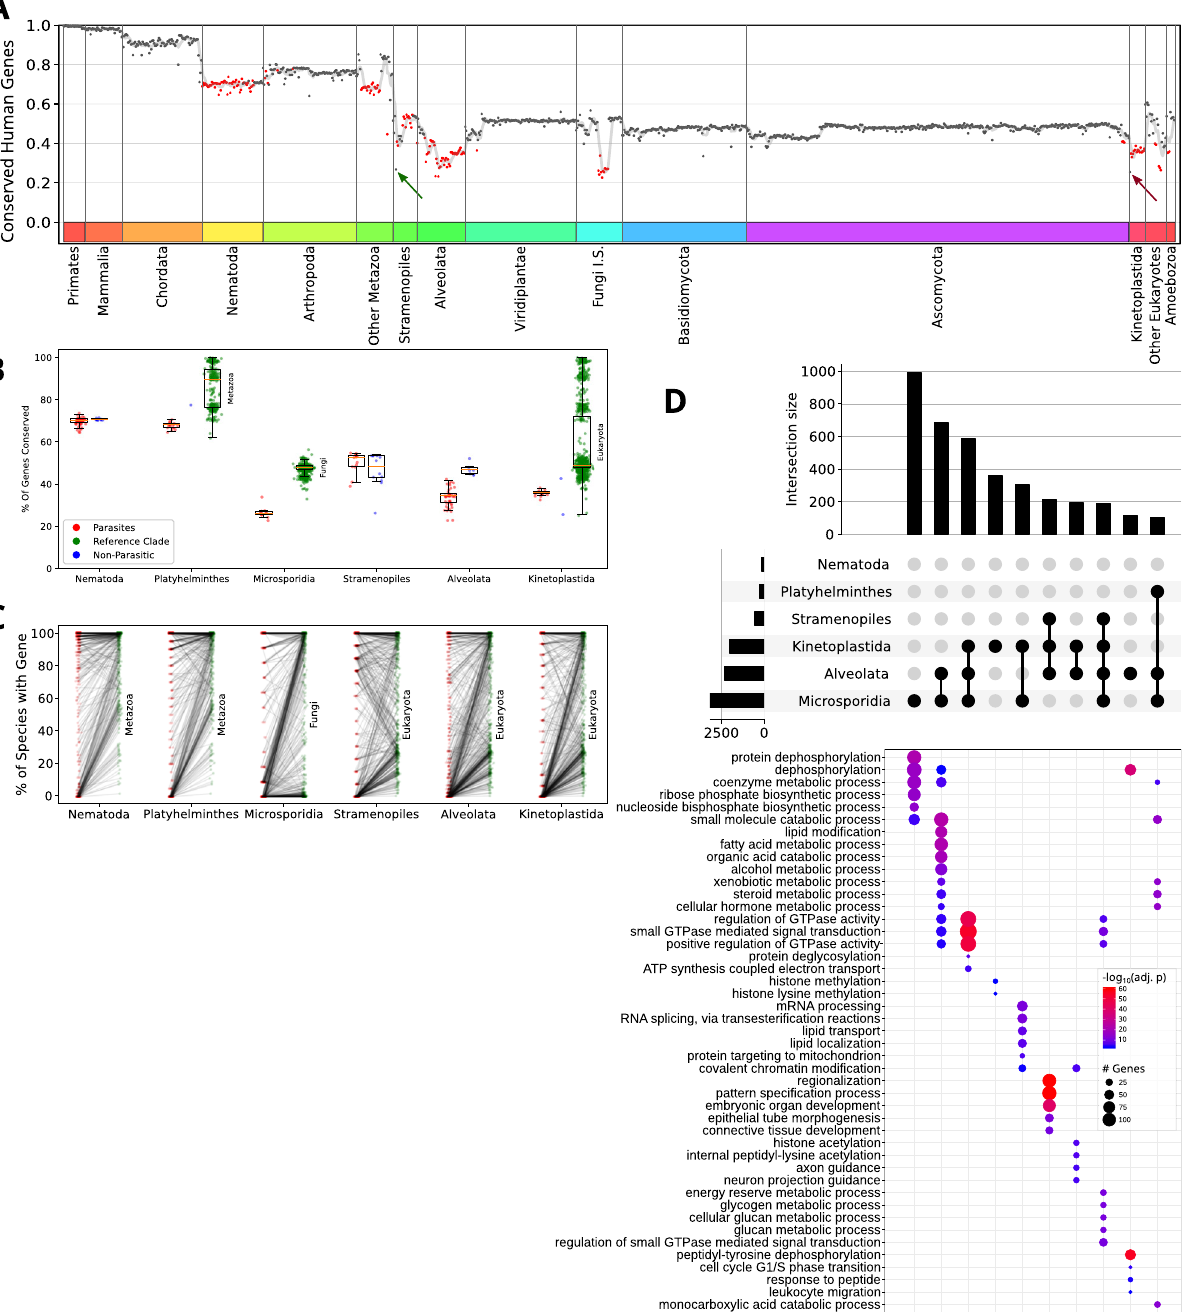
Fig. 7 Parasitic clades provide a key phylogenetic pro fi ling signal. The proportion of human genes found in each organism is shown on the y-axis, with parasites marked in red. Two non-parasitic organisms with lower conserved genes fraction are highlighted in green ( Nannochloropsis gaditana , in Stramenopiles) and red ( Perkinsela , in Kinetoplastida) arrows ( A ). The fraction of conserved genes was then compared for six clades with many parasitic organisms between parasites, non-parasitic organisms and a reference (parent) clade. Comparisons were made for each clade between parasitic organisms and the reference and non-parasitic organisms by a two-sided Mann – Whitney test; p-values are displayed for signi fi cant comparisons ( p < 0.05). The boxplot extends from the lower to upper quartile values of the data, with an orange line at the median. Whiskers denote 1.5 times the interquartile range. ( B ). In addition to the species level, comparisons were made by pairing the average conservation for each gene in the parasitic organisms (red) and reference clade (green) with a line connecting them ( C ). Genes that were fully lost, or with low conservation in at least one parasitic clade but highly conserved across all Eukaryotes, were tested for losses combinatorics across these clades. Genes in the top 10 intersections were checked for gene ontology overrepresentation (biological process ontology). The top fi ve terms by FDR adjusted p-value are shown for each combination ( D ). The upper panel presents the number of genes in each clade or intersection, with the relevant clades marked by black circles. The lower panels show the number and signi fi cance in the most relevant pathways. FDR — false discovery rate. Source data are provided as a Source Data fi